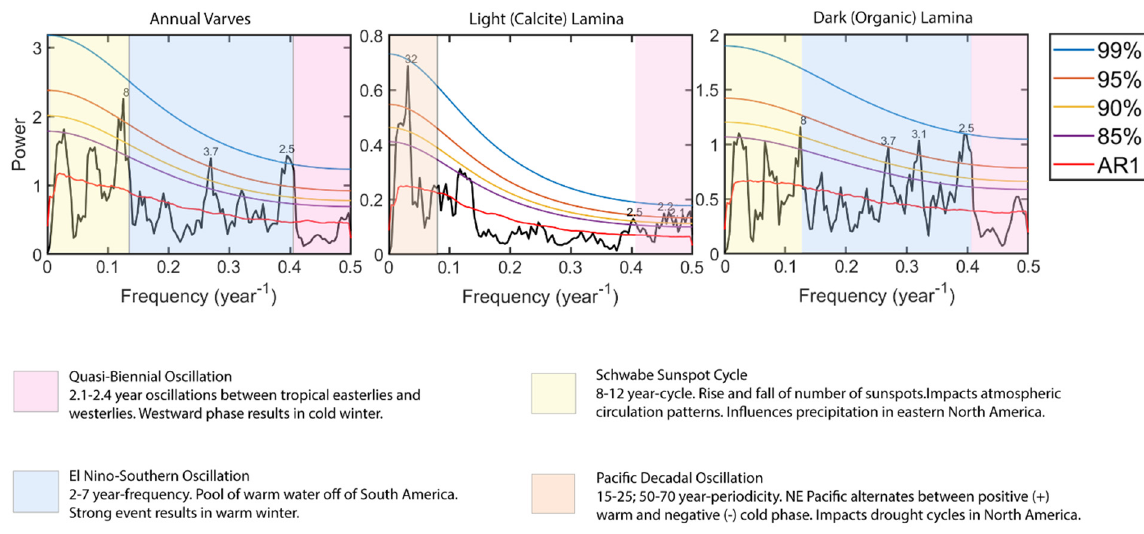
Figure 10. Spectral analysis of complete varves, light and dark laminae, showing likely climate cy- cles that we attribute to each frequency.